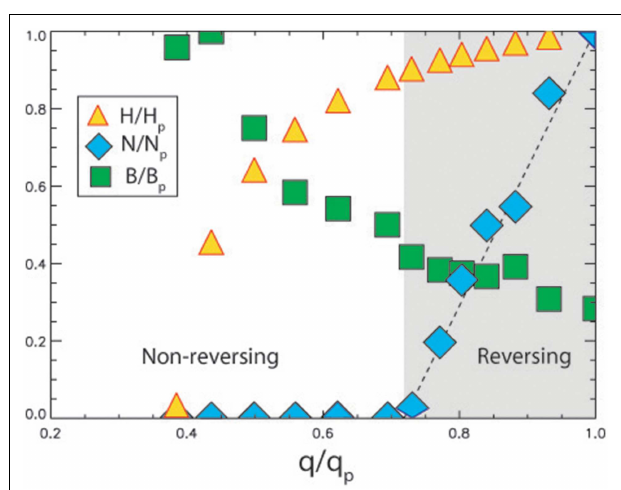
collapses, reducing CMB heat flux and reducing geodynamo polarity reversal frequency. Thermal instabilities are generated in the D"-region along the outer edge of the superplume (labeled PGZ—plume generation zone), leading to a concentration of large igneous provinces in that hemisphere. (C) The second superplume partially collapses, further reduces CMB heat flux and yields superchron conditions in the core. This collapse produces its own PGZ, leading to large igneous provinces concentrated in the opposite hemisphere.